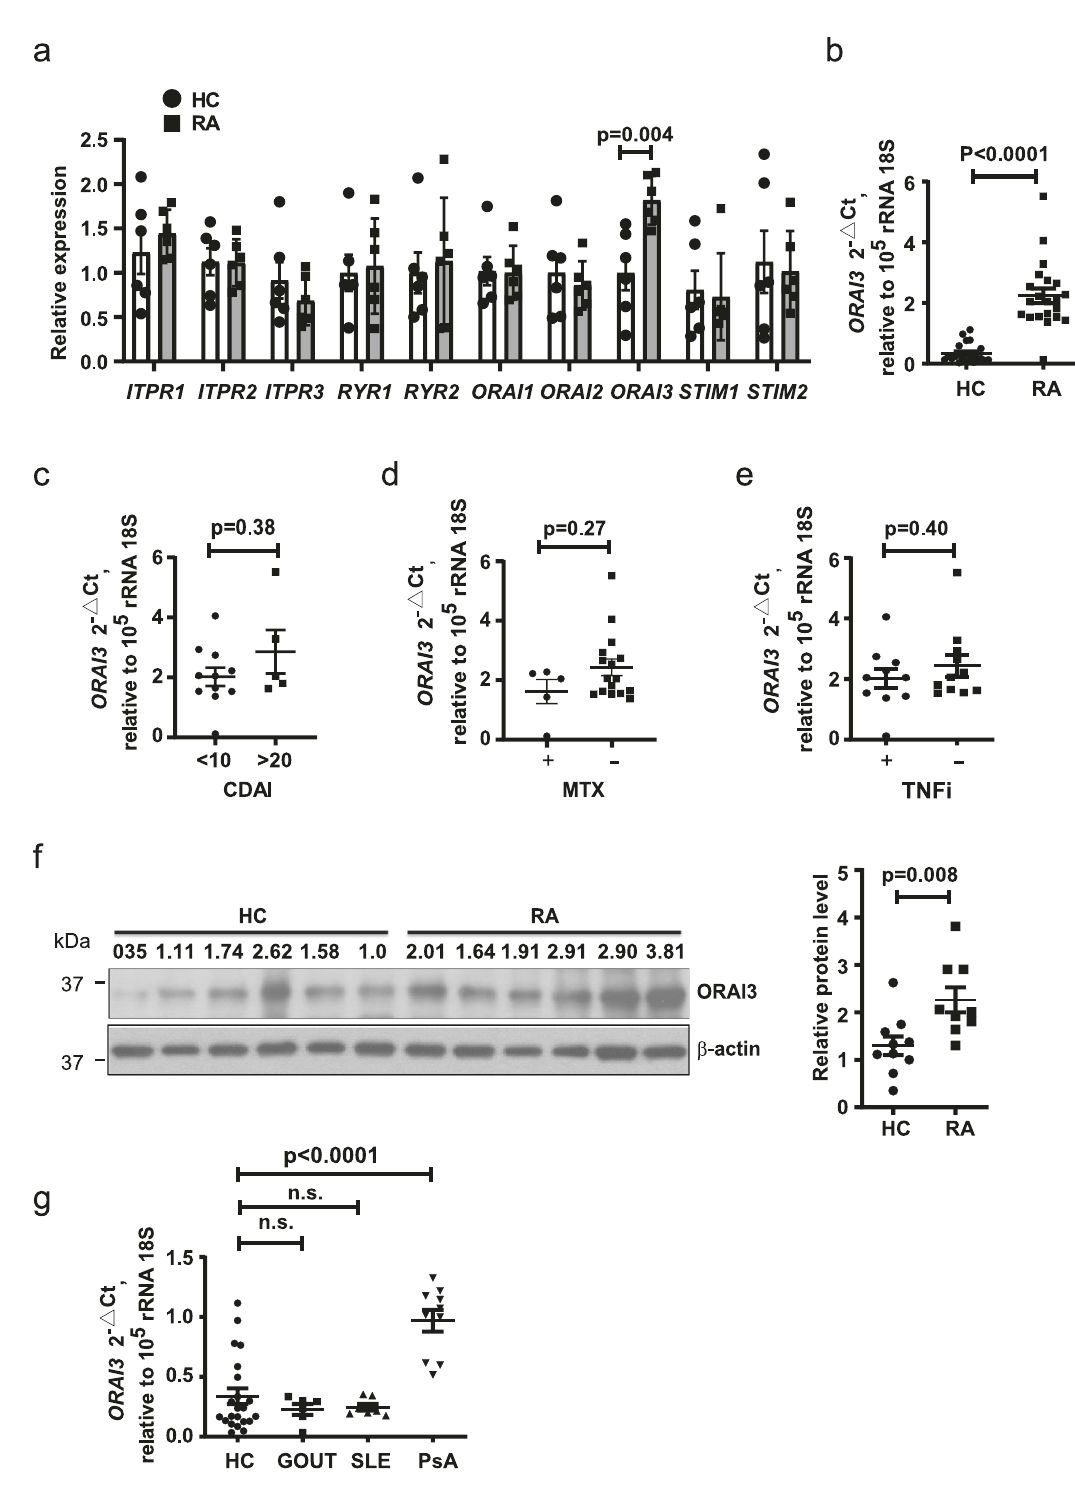
was smaller than the CRAC channel-mediated calcium in fl ux after TCR stimulation, but it was suf fi cient to induce Thr286 phosphorylation of CAMKII (Fig. 3b). Unexpectedly, AA also induced phosphorylation of the CD3 ζ chain (Fig. 3c) and induction of NUR77 expression in the absence of any additional TCR triggering (Fig. 3d). Moreover, stimulation with increasing concentrations of AA followed by culture for 24 h in the absence of exogenous AA or additional TCR stimulation resulted in a dose-dependent expression of CD69 (Fig.